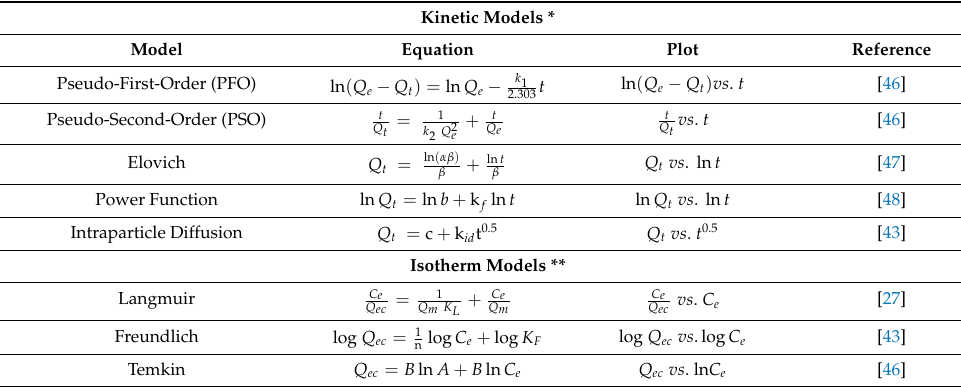
Table 1. List of adsorption kinetic and isotherm models.